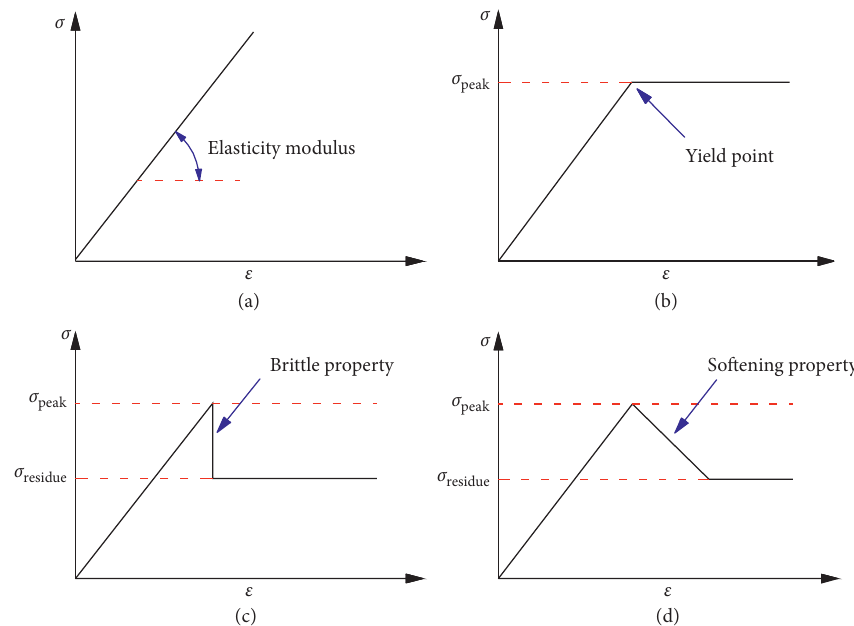
Figure 7: Four simplified intrinsic structure models commonly used for coal bodies: (a) pure elasticity; (b) ideal elasticity; (c) elasticity and brittleness; (d) strain